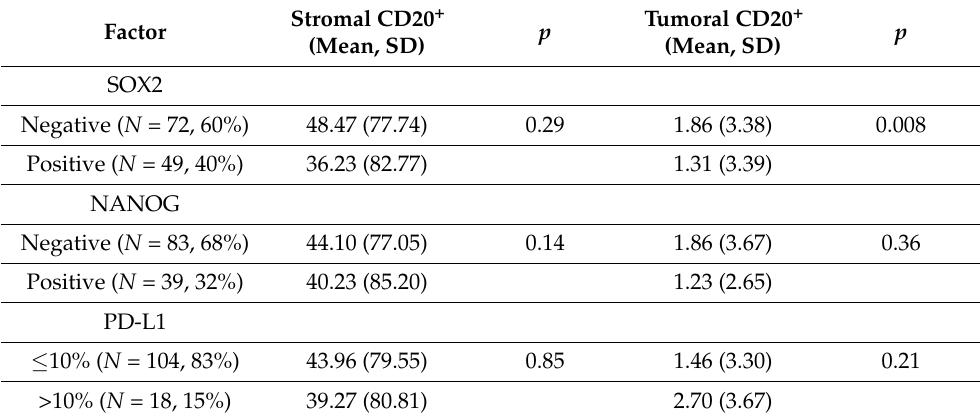
Table 4. Association between CD20 + TILs, PD-L1, and CSCs